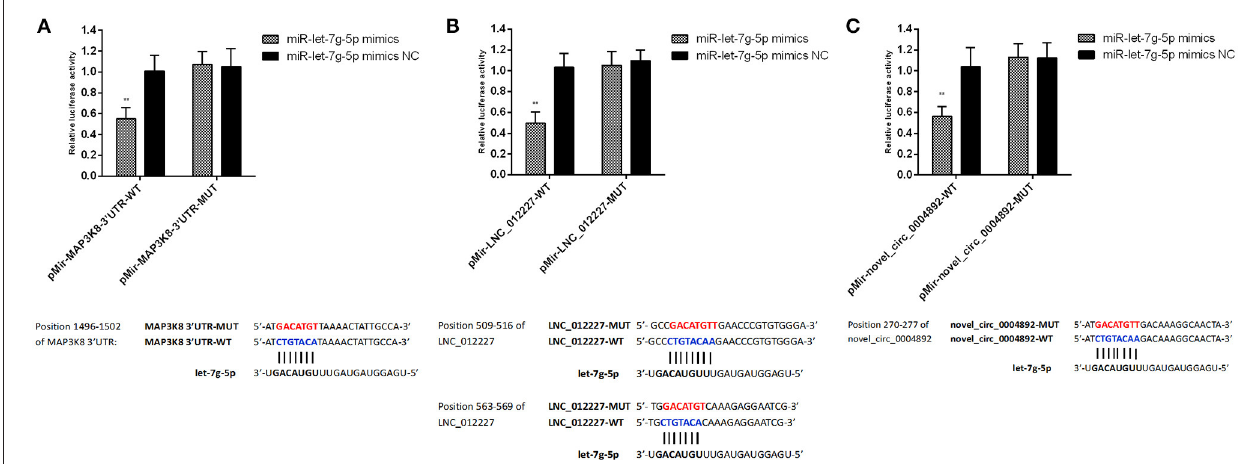
FIGURE 13 | Verification of target binding. (A) miR-let-7g-5p putative binding sites on MAP3K8-UTR. Blue letters indicate wildtype sites and red letters indicate mutated sites in the pMir-report luciferase reporter vector. Luciferase assays took place in 293T cells co-transfected with pMir-report-MAP3K8-UTR-WT and miR-let-7g-5p mimics or pMir-MAP3K8-UTR-MUT and miR-let-7g-5p mimics. (B) Putative binding sites for miR-let-7g-5p on LNC_012227. Blue letters indicate wildtype sites and red letters indicate mutated sites in the pMir-report luciferase reporter vector. The luciferase assays took place in 293T cells co-transfected with pMir-LNC_012227-WT and miR-let-7g-5p mimics, or pMir-LNC_012227-MUT and miR-let-7g-5p mimics. (C) Putative binding sites for miR-let-7g-5p in novel_circ_0004892. Blue letters indicate wildtype sites and red letters indicate mutated sites in the pMir-report luciferase reporter vector. The luciferase assays took place in 293T cells co-transfected with pMir-novel_circ_0004892-WT and miR-let-7g-5p mimics, or pMir-novel_circ_0004892-MUT and miR-let-7g-5p mimics. Error bars indicate the mean ± SD of triplicate experiments. ** P <